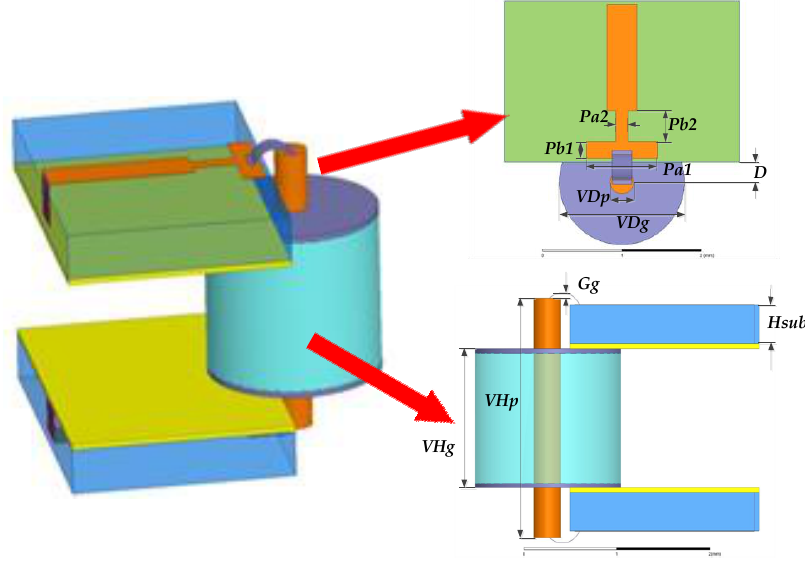
Figure 18. Models of the vertical interconnection. Table 5. Parameters of the matching structure in the vertical interconnection.